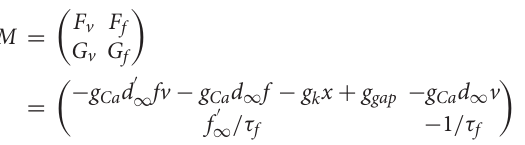
FIGURE 6 | Effects of the outward current. Reducing outward current ( I NaK ) also has similar effects of increasing inward current. (A) When the outward current was reduced ( g NaK 0.3 µ A/ µ F), EADs occured without the non-excitable gap region. Near the gap region, more EADs were observed (2 EADs). (B) g NaK = Control. (C) g NaK 0.6 µ A/ µ F. Large outward current reduces APD. Since APD is shorter, the action potential in the proximal region cannot provide enough source = current to excite cells in the distal region. (D) APD vs. g NaK